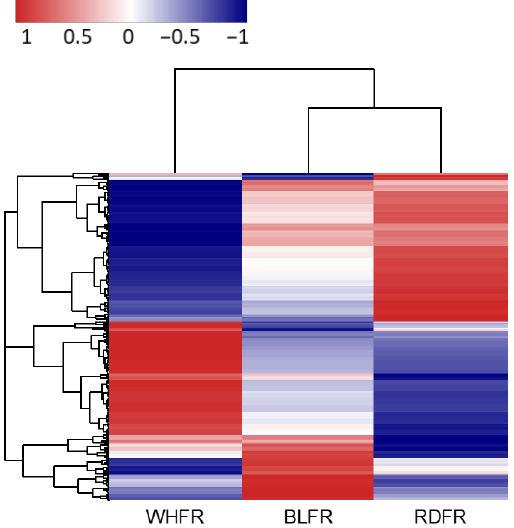
Figure 8. Differentially expressed genes of fruit with different light treatments. Red and blue rectangles indicate higher and lower levels, respectively, than the mean of all treatments. Values indicate the z-score in the legend. BLFR, RDFR, and WHFR refer to blue, red, and white light-treated fruits, respectively.